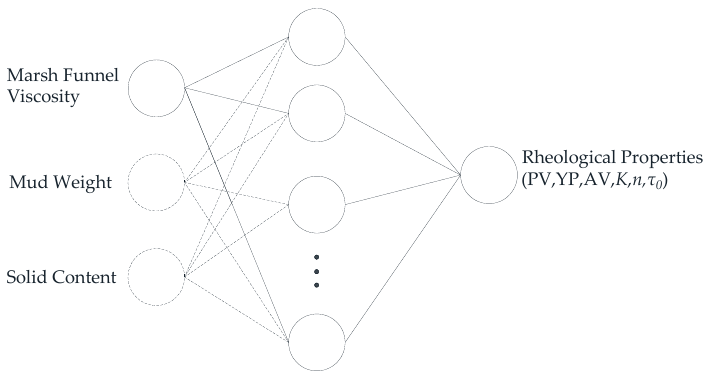
Figure 7. The ANN model for rheological properties estimation.